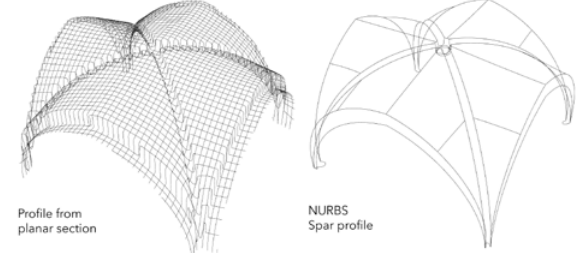
Figure 5. From profiles of planar sections to a custom NURBS spar profile